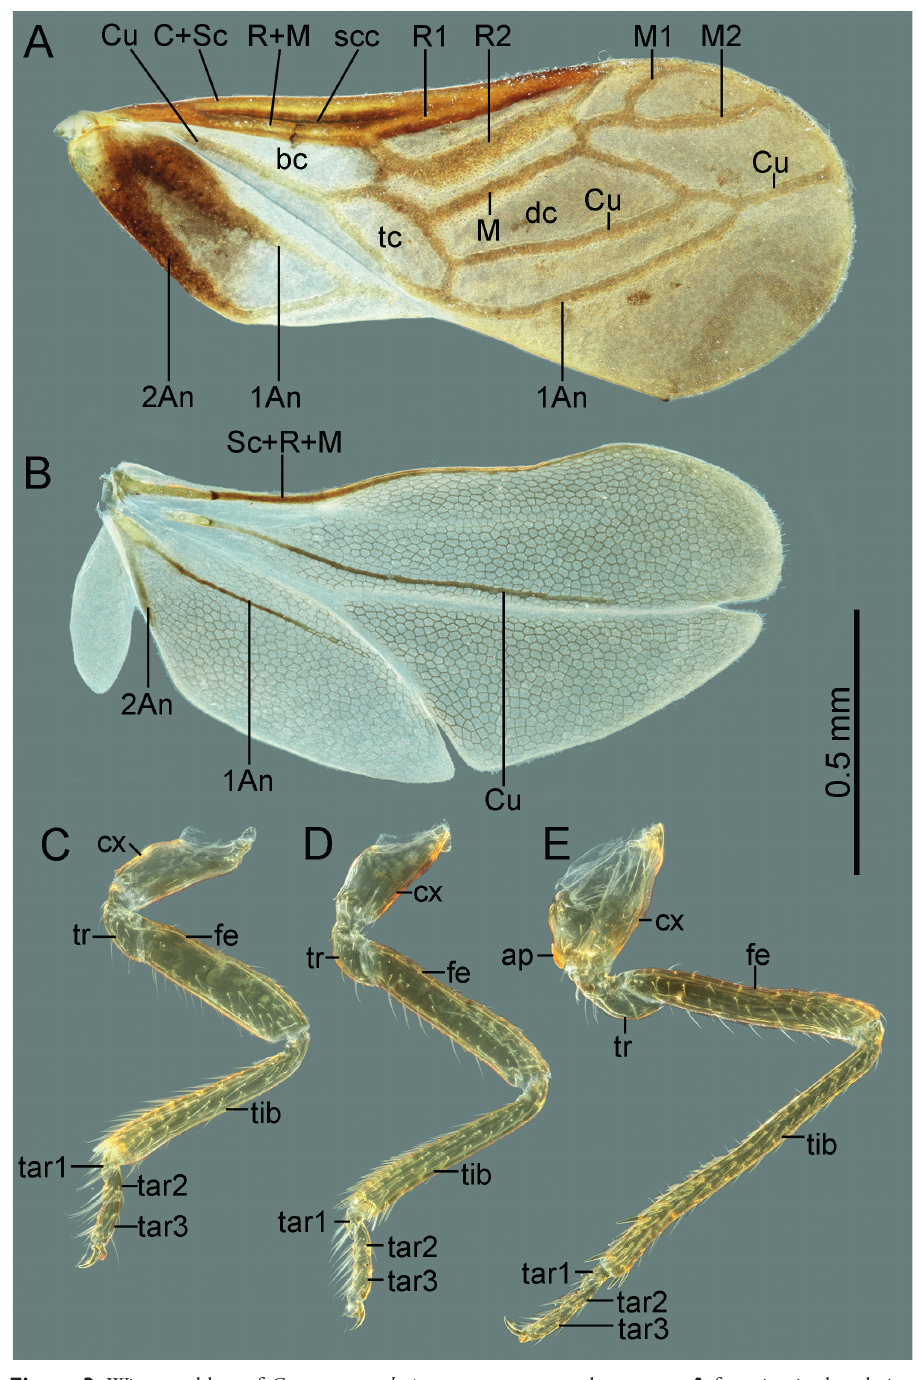
Figure 3. Wings and legs of Cornonannus bui gen. et sp. nov., male paratype A forewing in dorsal view B hindwing in lateral view C foreleg D middle leg E hind